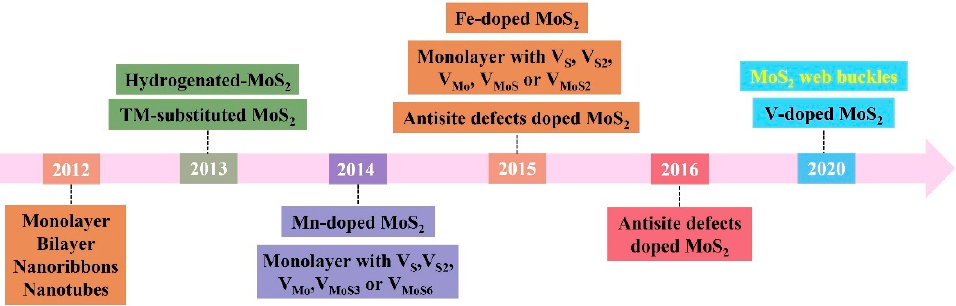
Figure 1. Timeline showing key developments of strain-modulated magnetism in MoS 2 . Black font represents the theoretical progress; yellow font represents the experimental progress.